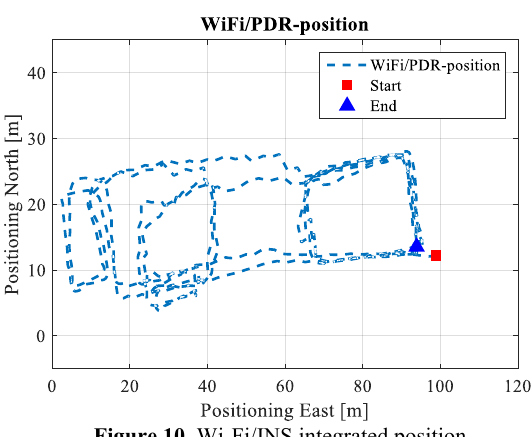
Figure 9. Wi-Fi estimated position